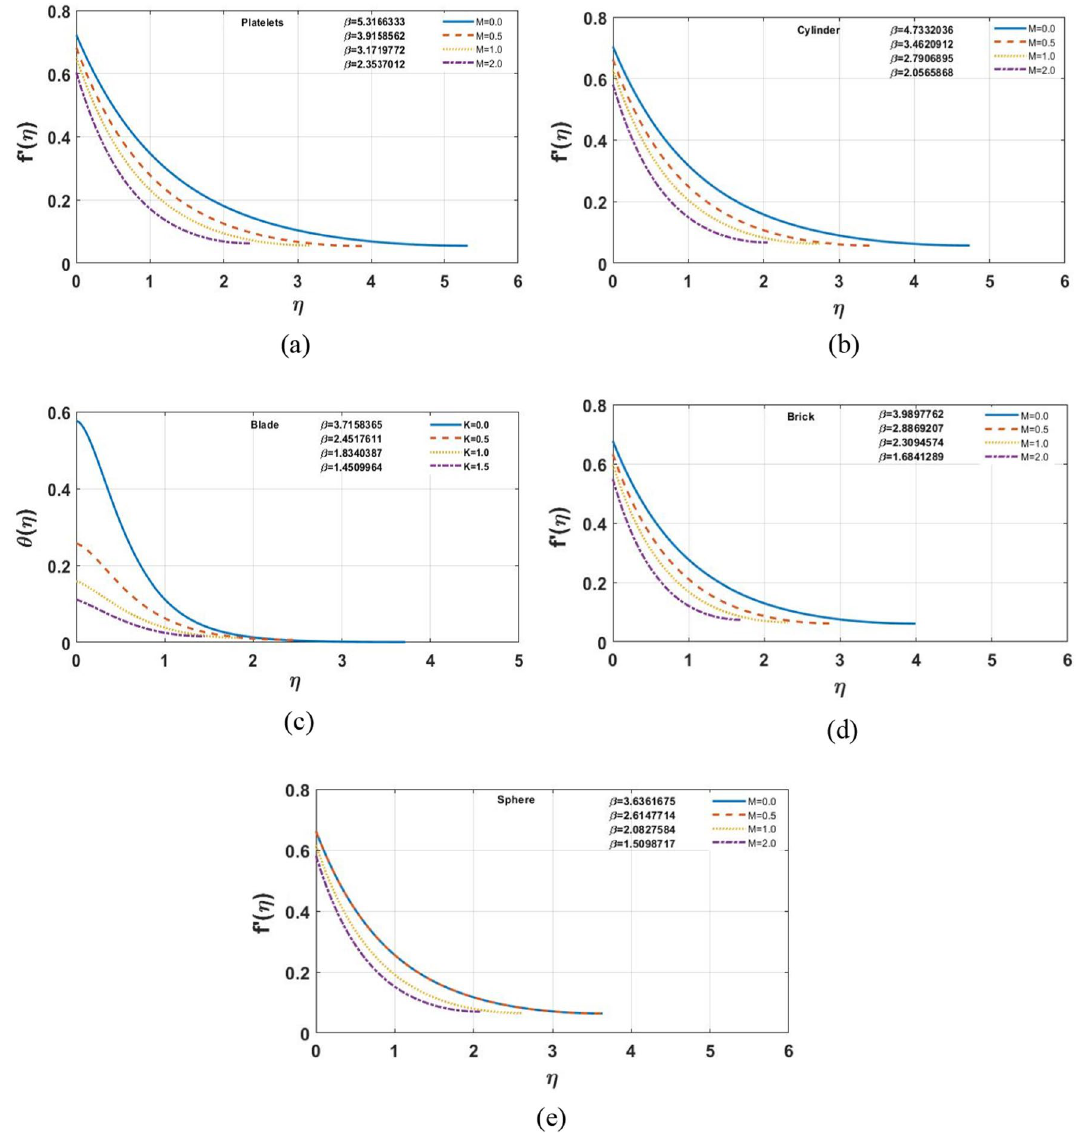
0.4, M 1.0, ϕ 0.02, γ = = =